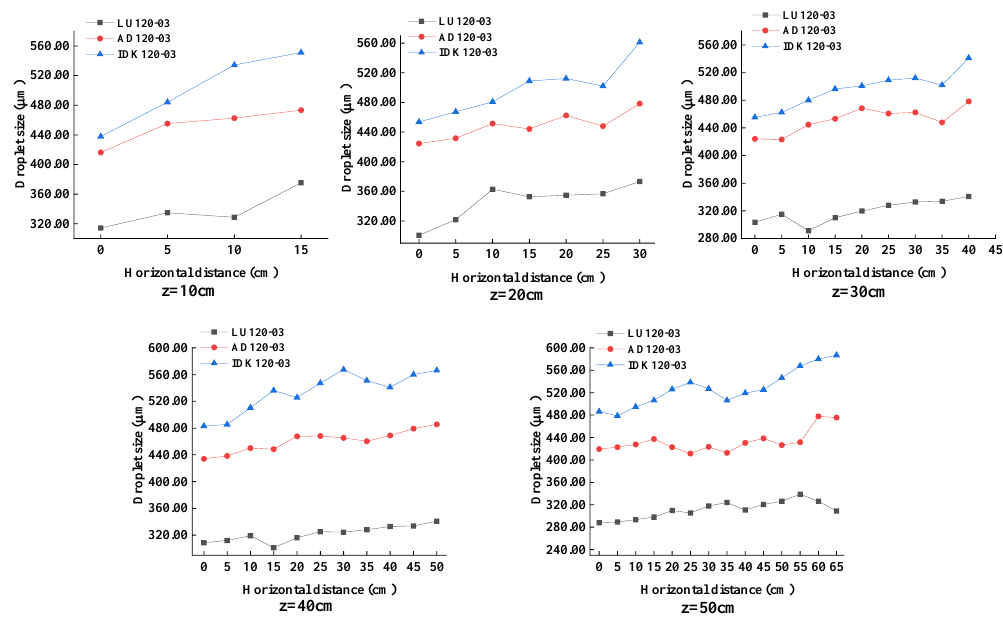
Figure 7. Horizontal direction droplet size D X distribution in different nozzles.